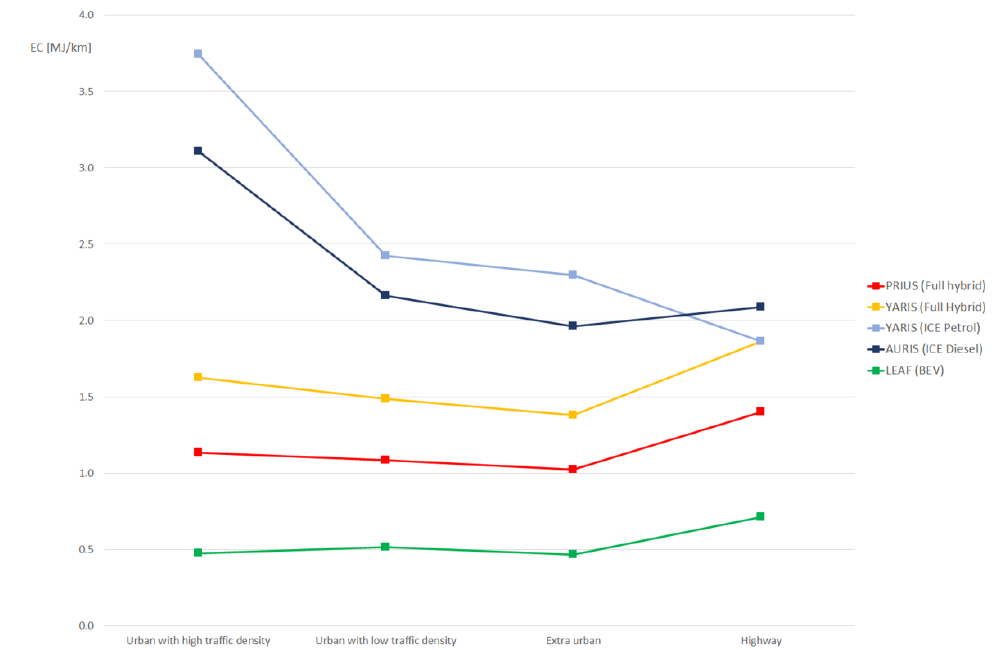
Figure 6. Energy consumption of vehicle tested in the test path (MJ/km).